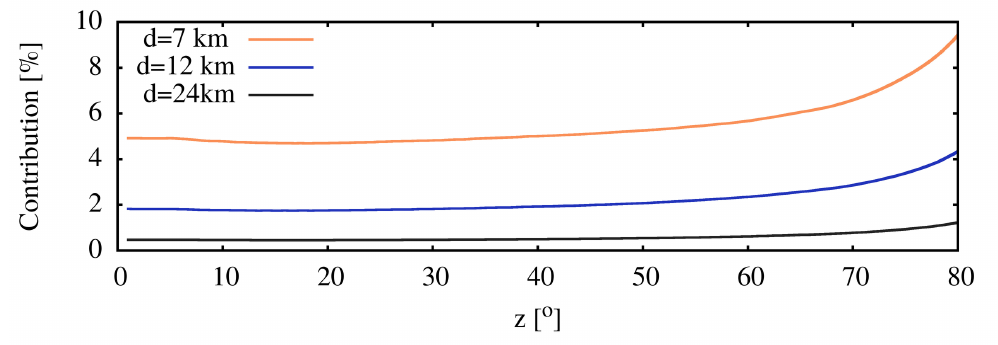
Figure 15. View on the horizon at the second observation point close to Szásztelek. The white arrow indicates the light of the gas storage station.